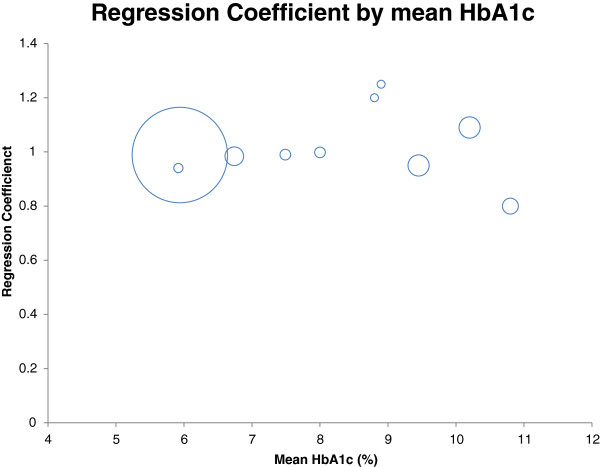
The mean HbA1c values from the studies are compared with the regression coefficient the study generated. The marker size is proportional to study size.